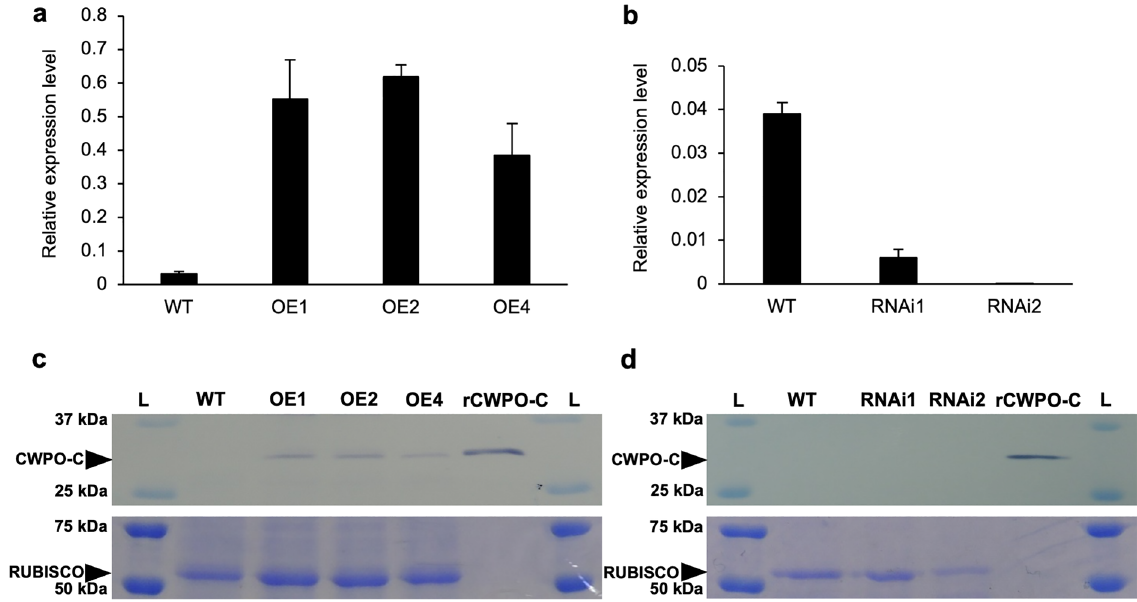
Fig. 5 Expression of CWPO-C and CWPO‑C protein in transgenic poplar lines. a , b CWPO-C expression levels in 6‑week‑old overexpression (OE) and suppression (RNAi) transgenic poplar lines. a CWPO-C expression in WT and three OE lines. b CWPO-C expression in WT and two RNAi lines. Relative expression levels (mean standard deviation) measured by RT‑qPCR were calculated from three biological replicates. Data are presented as ± relative transcript abundance normalized to UBQ expression. c , d Western blot analysis of CWPO‑C protein in transgenic lines using an anti‑CWPO‑C antibody. c WT and three OE lines. d WT and two RNAi lines. Upper panels: recombinant CWPO‑C protein as a standard marker (rCWPO‑C, arrow). Lower panels: proteins stained with Coomassie brilliant blue; arrow indicates Rubisco. L: molecular weight